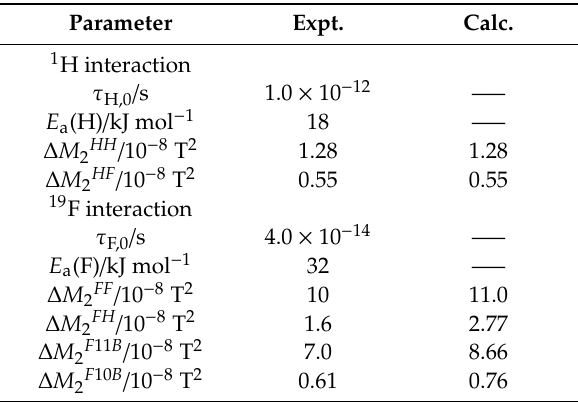
Table 3. Activation parameters for the isotropic reorientation of BF 4− and the torsional flipping of 4,4’- bipyridine in 1 determined from dipolar relaxation data.